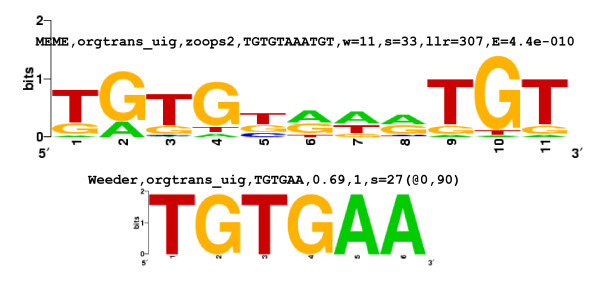
Sequence logos for TGTG motif-sets identified in the upstream regions of the organellar translation machinery group of genes. Motif-sets are given in Additional file 2:48 and logo captions are explained in the legend to Figure 1.